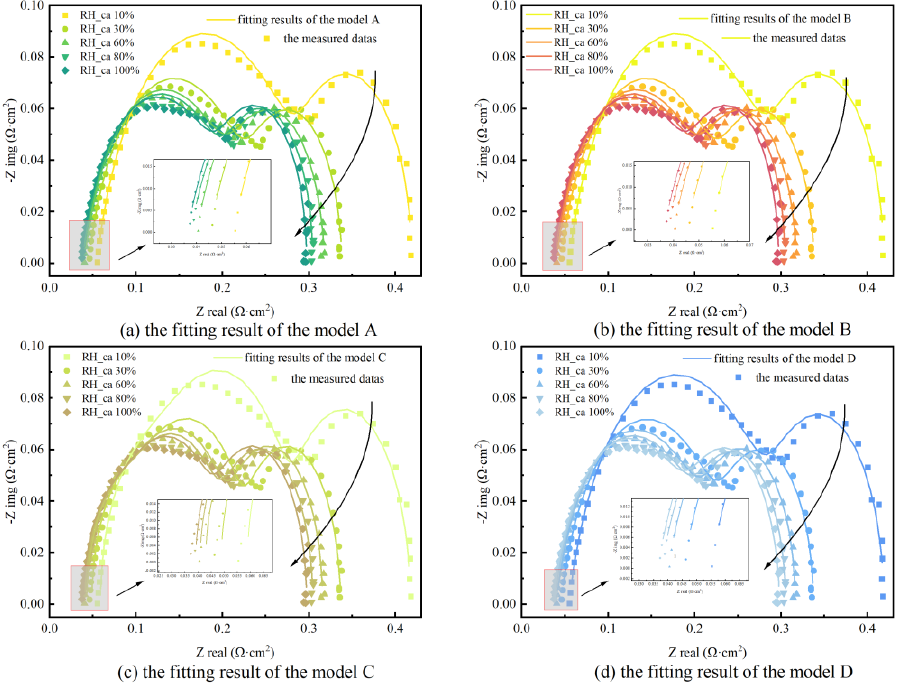
Figure 6. The model-fitting results under different air humidity: ( a ) the fitting result of the model A; ( b ) the fitting result of the model B; ( c ) the fitting result of the model C; ( d ) the fitting result of the model D. Table 4. Chi-square values of the model fitting results under different air humidity.